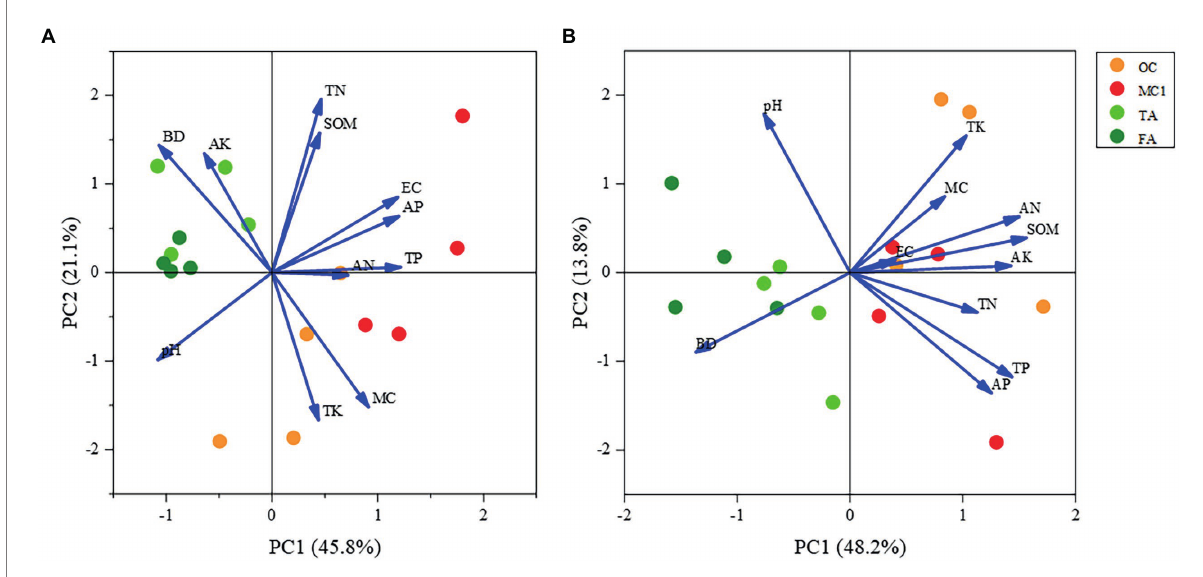
FIGURE 5 PCA of soil physicochemical properties. The PCA of soil physicochemical properties at the 0-15 cm soil depth (A) and soil physicochemical properties at the 15-30 cm soil depth (B)